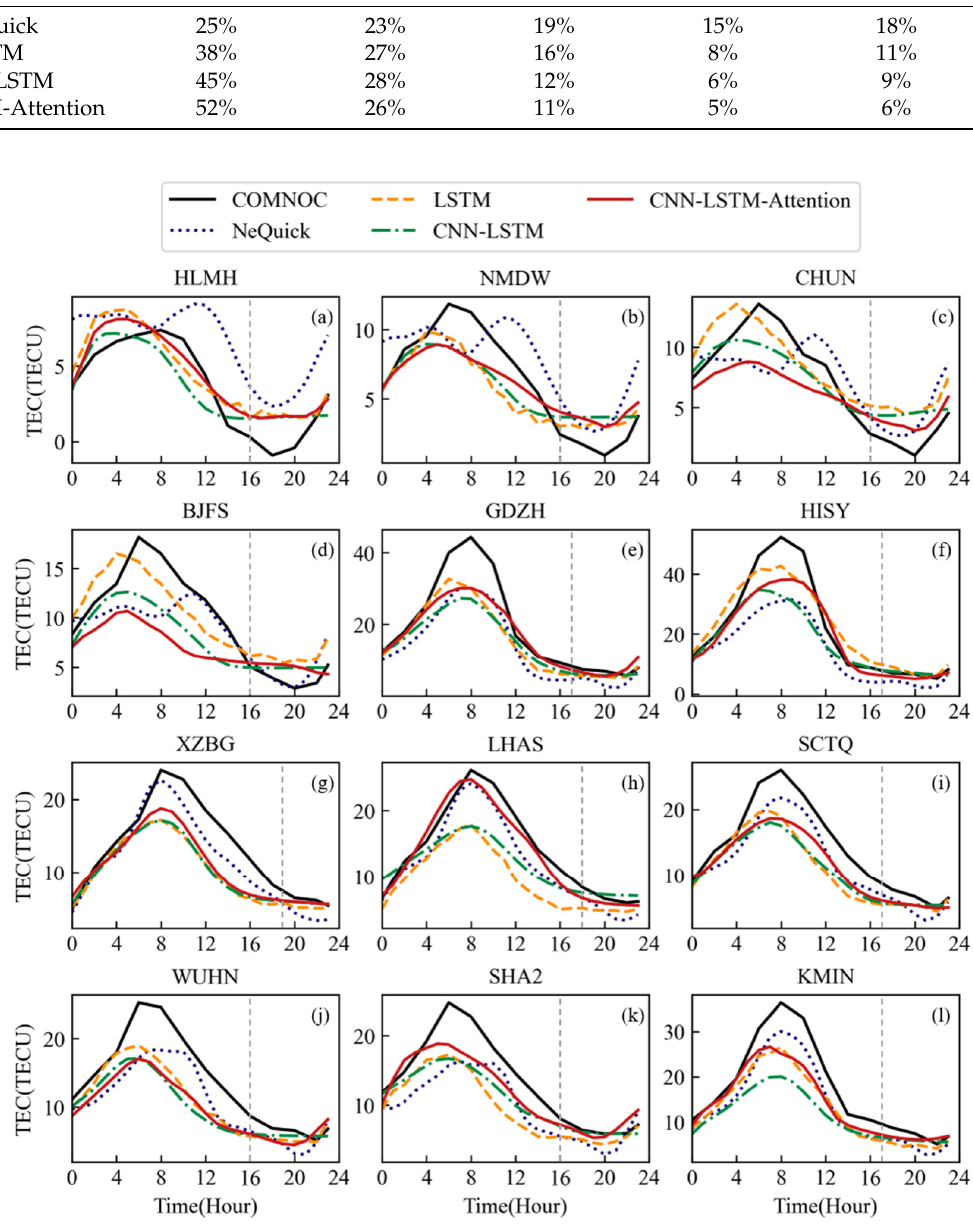
Figure 13. ( a – l ) Comparison of GNSS measured values (black solid line), NeQuick (blue dotted line), LSTM (yellow dotted line), CNN-LSTM (green dotted line), and CNN-LSTM-Attention (red solid line) models forecasted values for 12 stations on magnetic storm day. The gray dotted line indicates midnight LT.